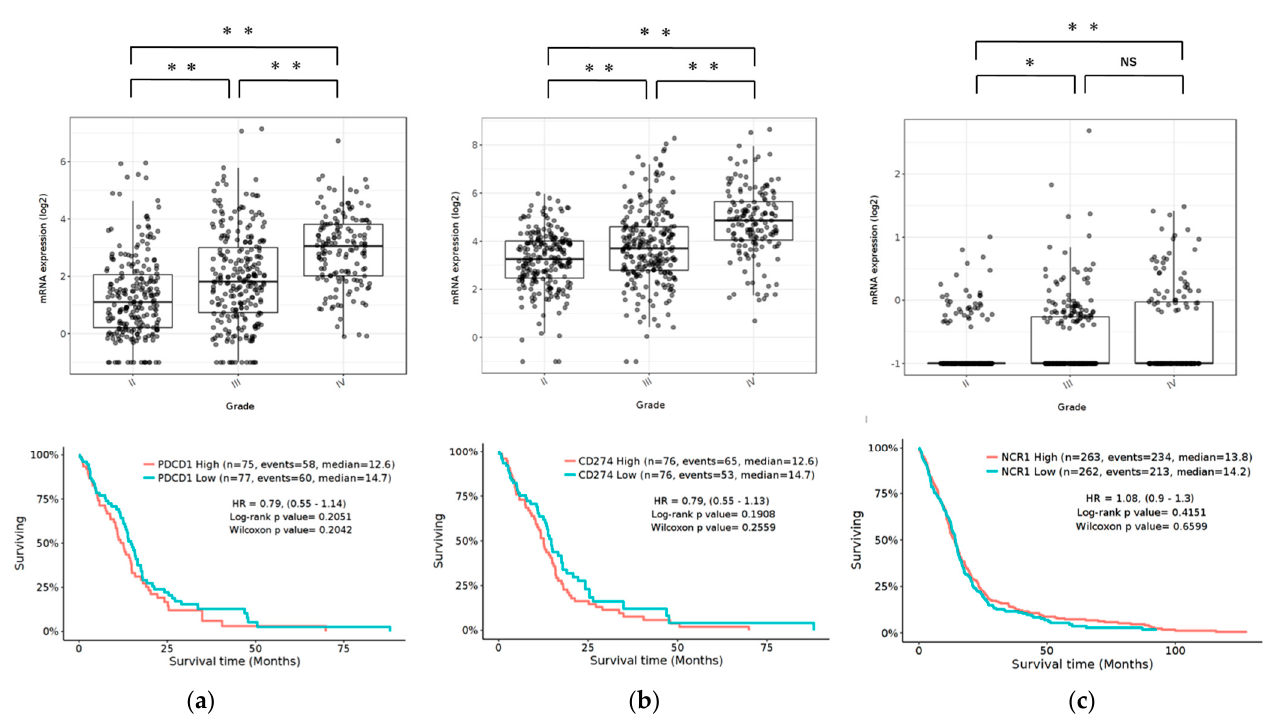
Figure 1. Expression of PD-1, PD-L1, and NCR1 in gliomas in the TCGA data set. Top : mRNA expression of PD-1 ( a ), PD-L1 ( b ) and NCR1 ( c ) according to the WHO grading system. Bottom : Kaplan-Meier curves based on mRNA expression. p values were determined using Turkey’s Honest significant difference test. ** p < 0.001, * p < 0.01, NS: not significant.